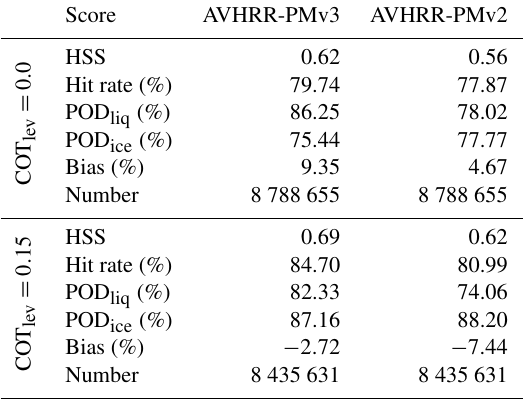
Table 4. Cloud-top height (CTH) validation results for Cloud_cci AVHRR-PMv3 when compared with CALIOP. Validation results for AVHRR-PMv2 are also reported. Validation measures are stan- dard deviation (SD) of the error and the mean error (bias). In ad- dition the number of collocated pixels is given. All scores are separated into liquid and ice clouds (both Cloud_cci dataset and CALIOP had to agree on phase) and into three cloud optical depth levels (COT lev ) representing the top-down COT into the cloud at which the reference CALIOP CTH was taken.